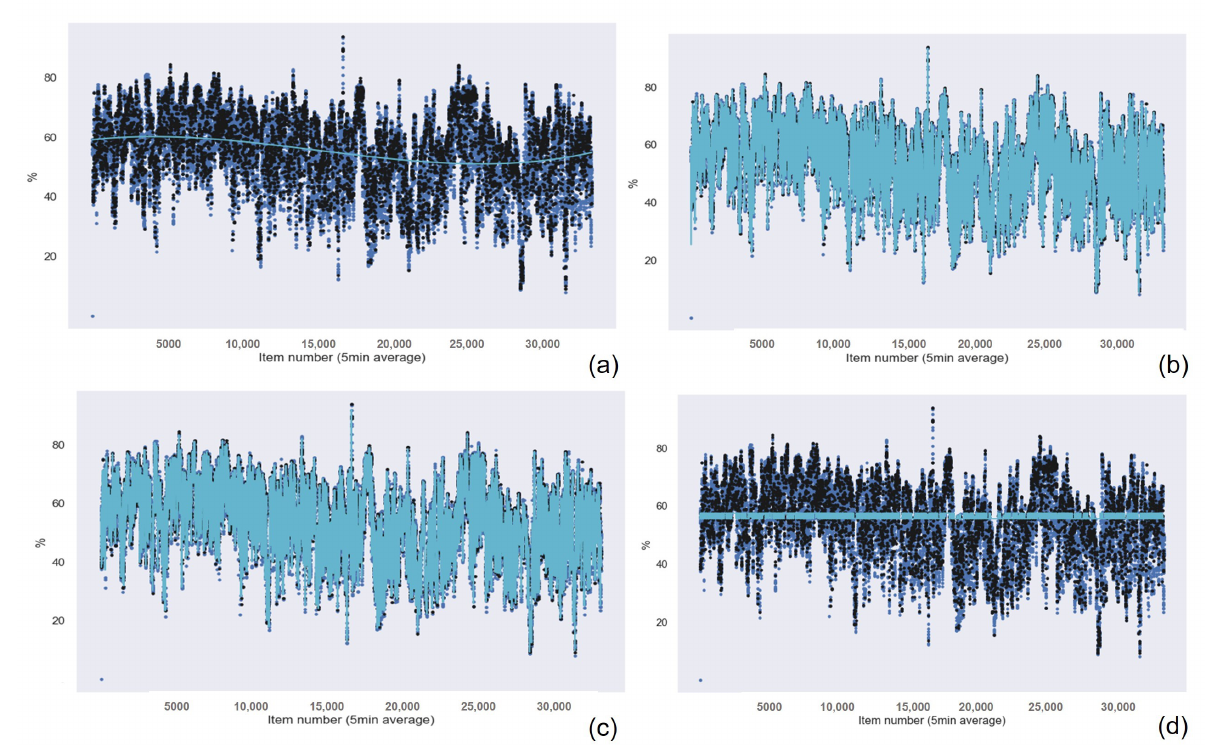
Figure A14. Cont